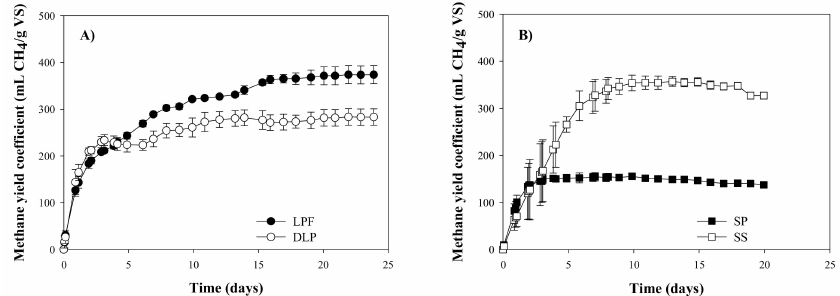
Figure 1. Accumulated methane production for ( A ) LPF and DLP and ( B ) SP and SS expressed as mL CH 4 / g VS against